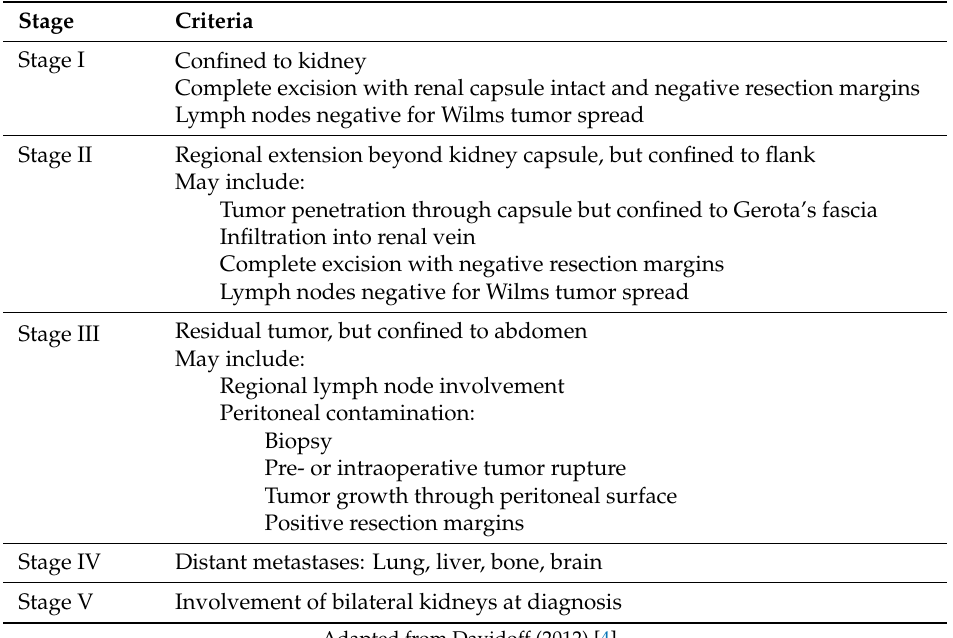
Table 1. Wilms tumor stages according to the Children’s Oncology